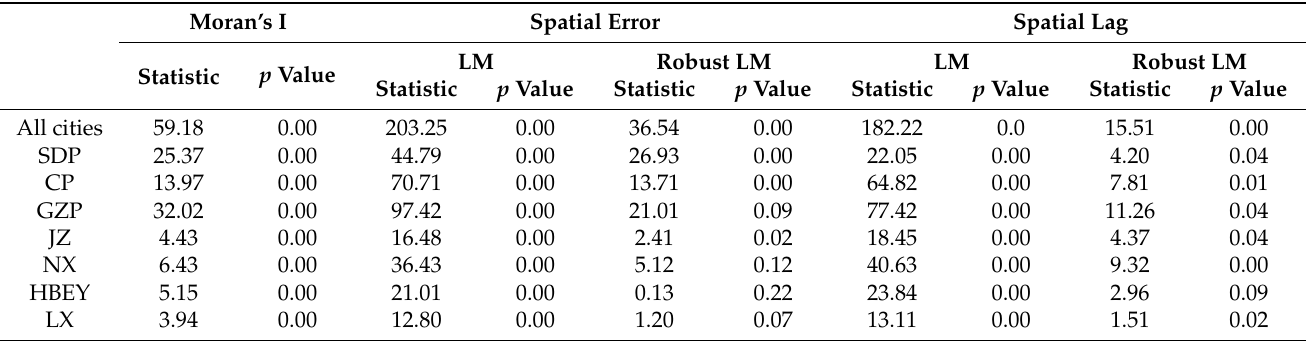
Table 3. LM test of spatial panel (absolute β convergence).